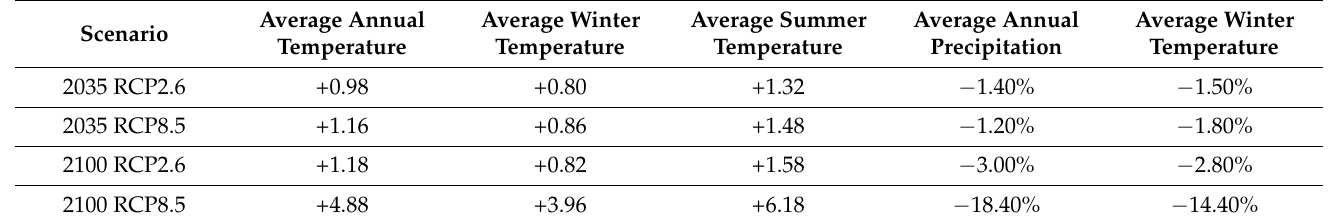
Table 8. Calculation of temperature and precipitation variation for each Global Change scenario